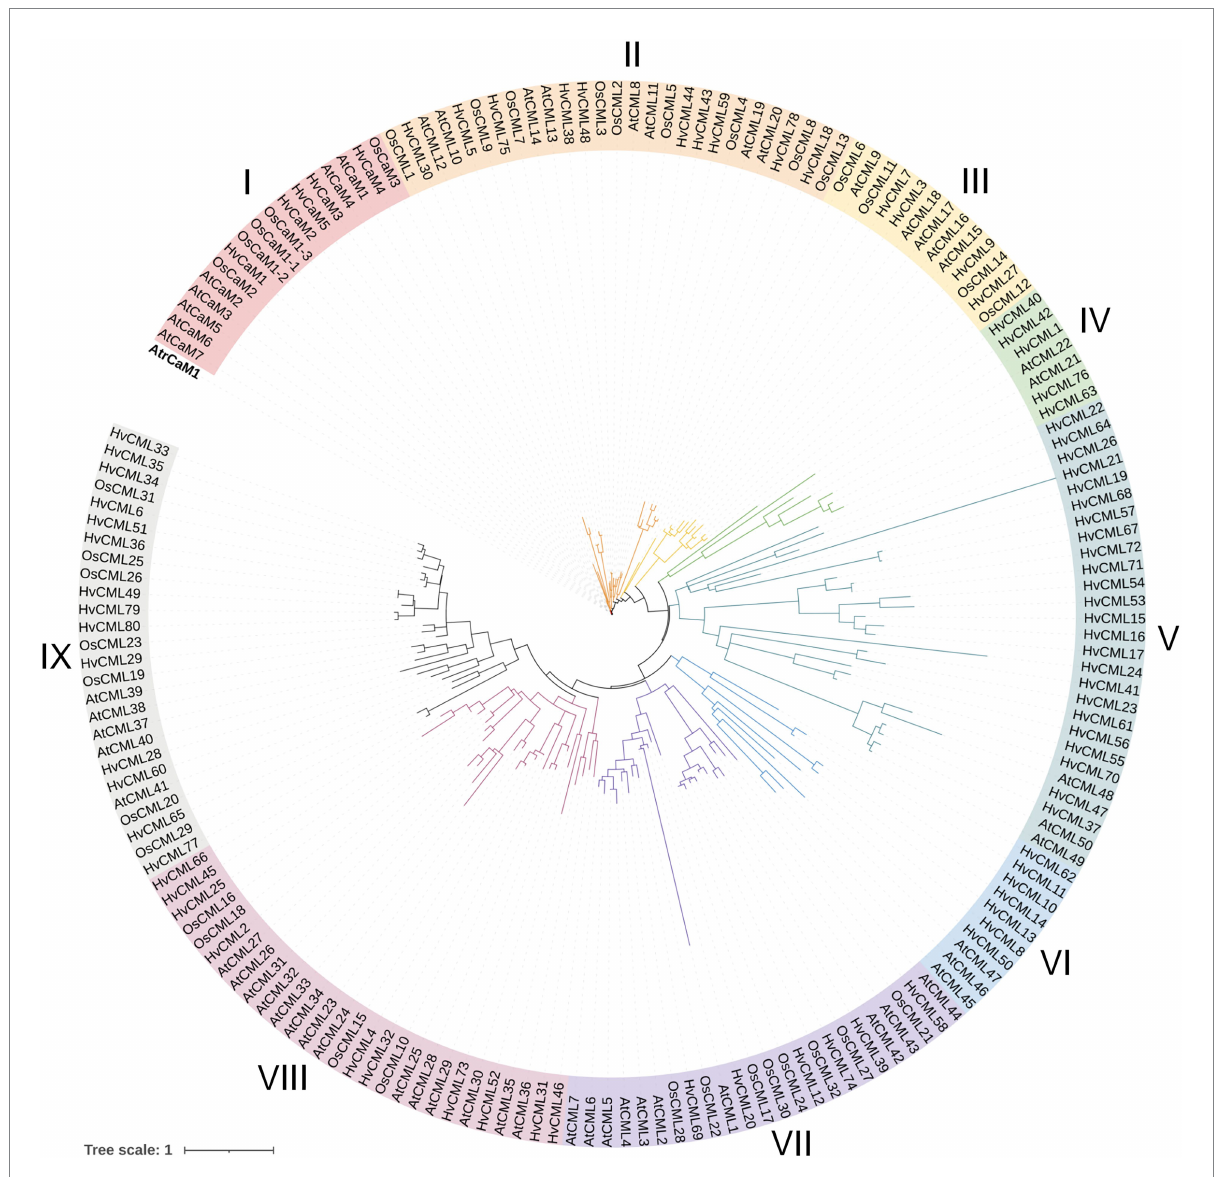
FIGURE 1 Phylogenetic tree of CaM and CML family proteins from barley, Arabidopsis and rice. CaM1 from Amborella trichopoda was used as outgroup. Atr, Amborella trichopoda ; Hv, Hordeum vulgare ; Os, Oryza sativa ; At, Arabidopsis thaliana